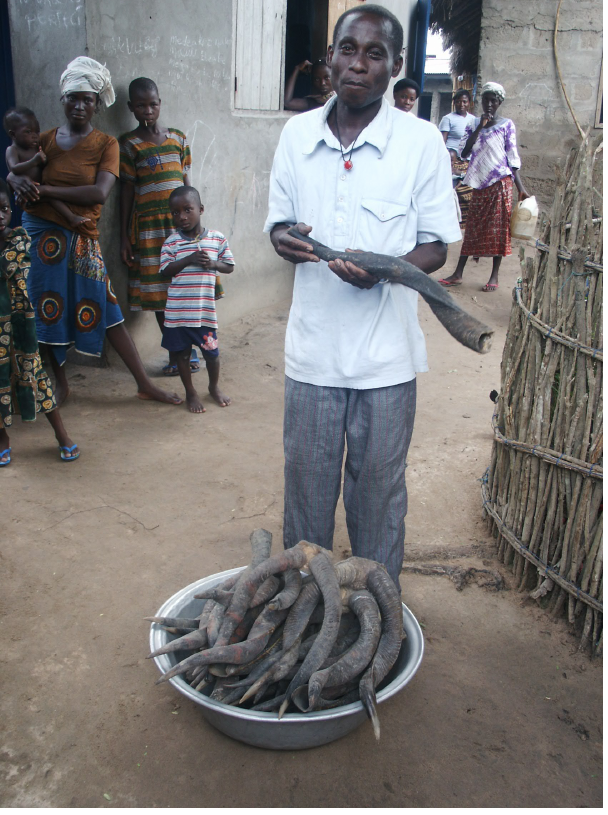
Fig. 3 . A hunter from Agorbledokui offering his collection